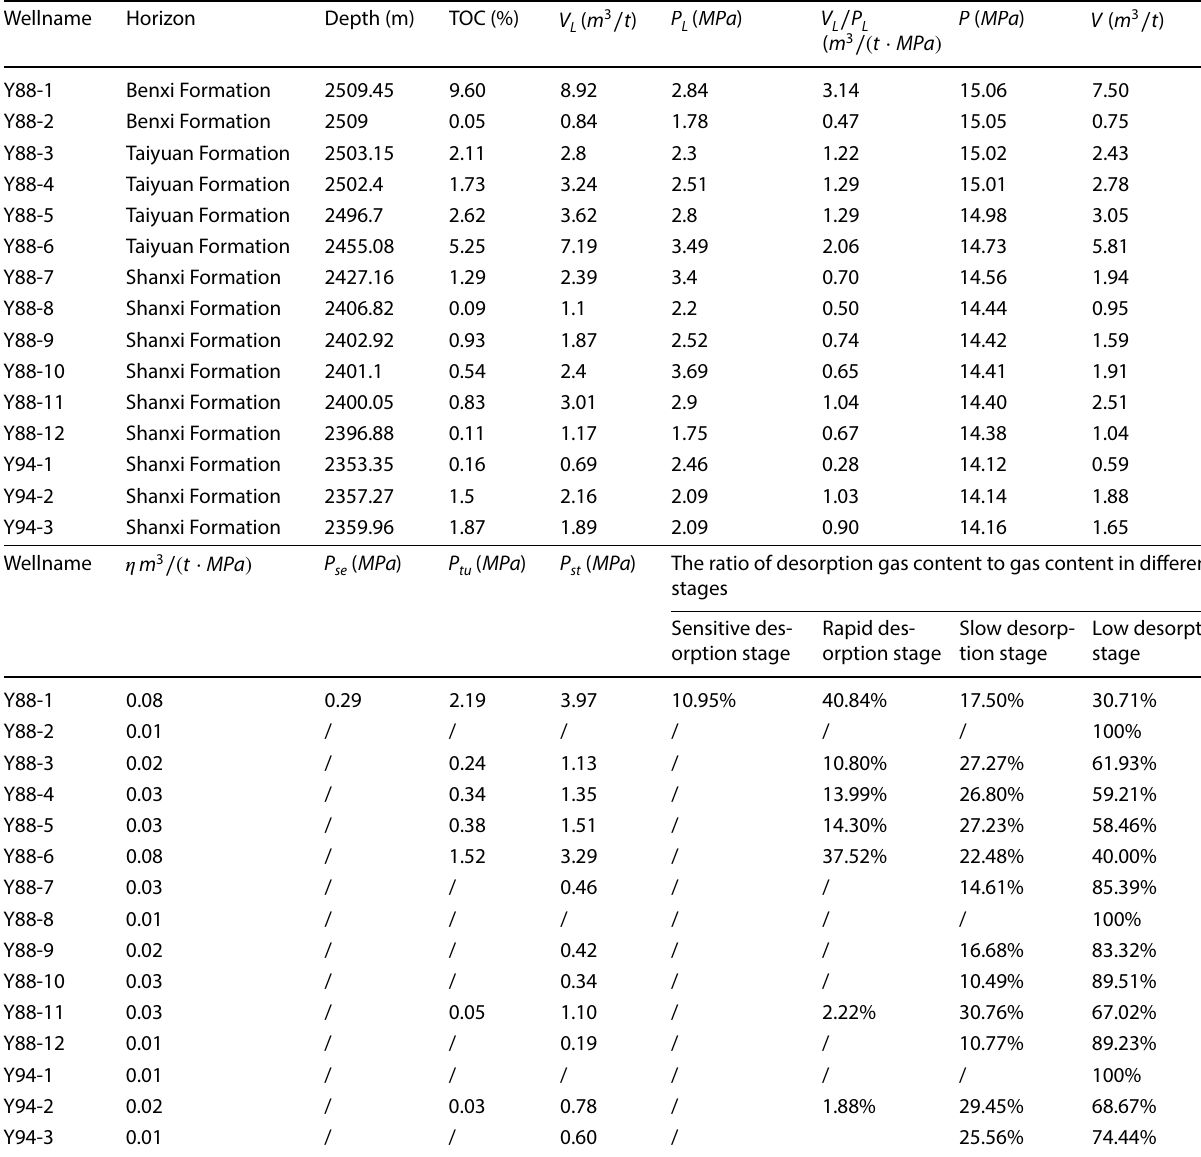
Table 2 Isotherm adsorption parameter table of shale in Yulin area Wellname